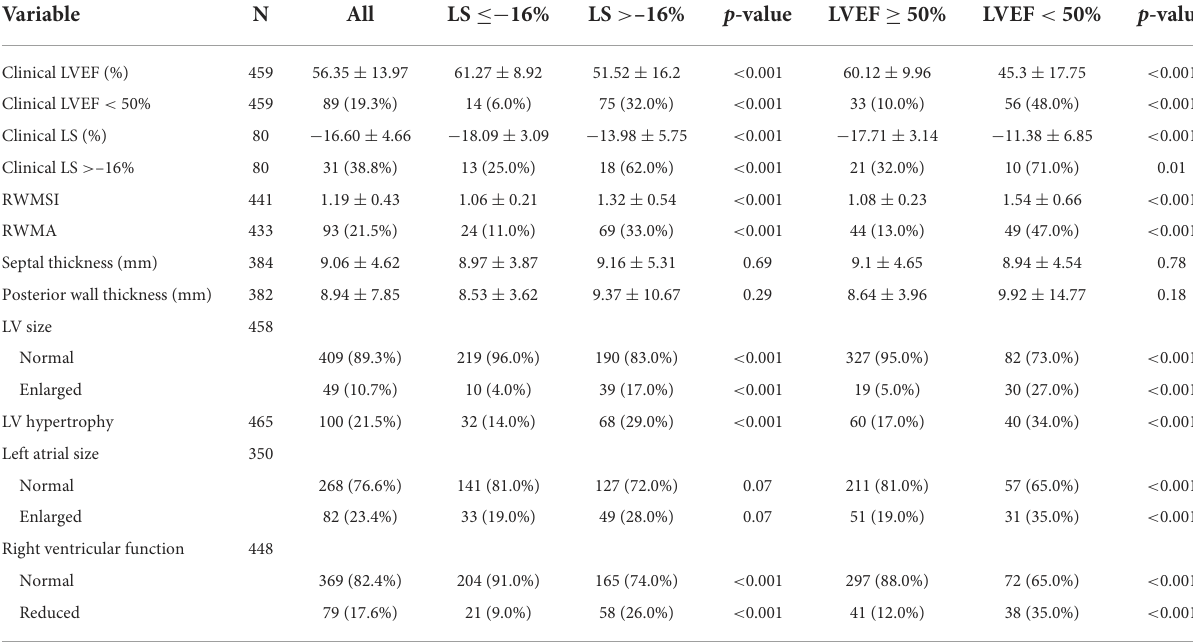
TABLE 3 Echocardiographic analysis of cardiac structure and function according to automated indices of LS ( > –16%) and LVEF ( < 50%). Variable